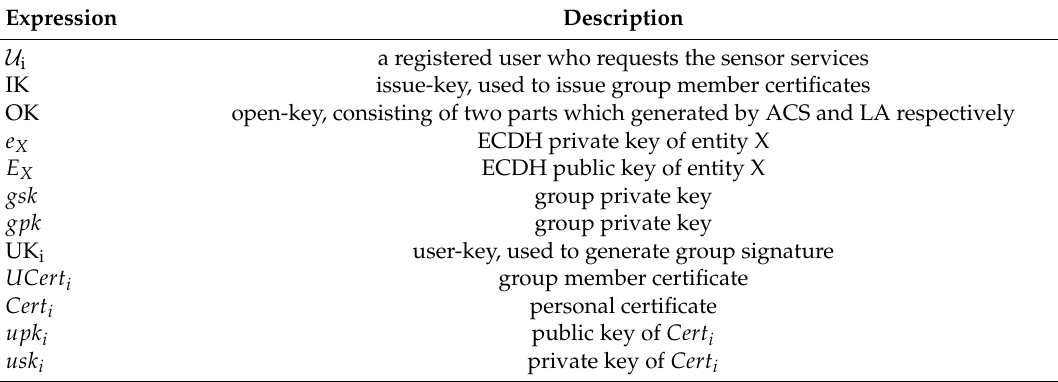
Table 2. Terminology and notation agreement of the privacy-preserving model of eHAPAC. Expression